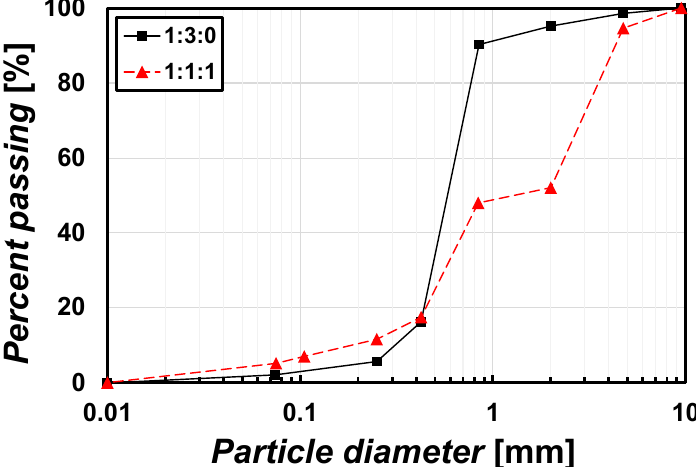
Figure 3. Particle size distribution of test